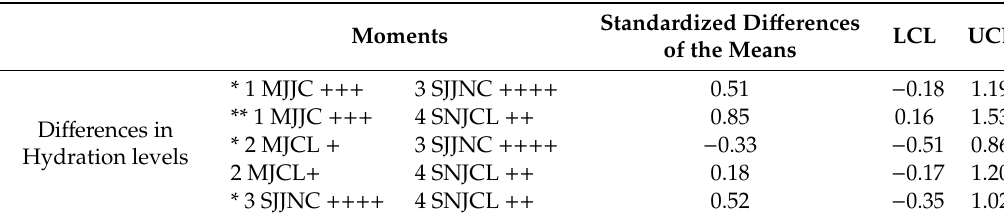
Table 7. Standardized di ff erences of the variable analyzed hydration levels at the di ff erent moments: